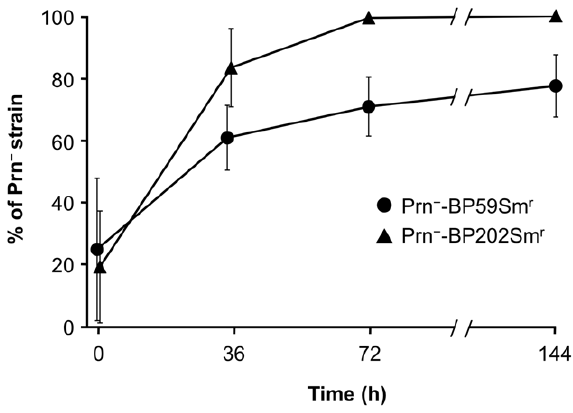
Figure 6. Population dynamics of Prn 2 strains in in vitro growth competition assay. Prn + back-mutants and parental Prn 2 strains were mixed in the ratio 4:1 (Prn + -BP59Sm r versus BP59Sm r or Prn + -BP202Sm r versus BP202Sm r ) and cocultured in mSS broth at 36 u C. The bacterial cultures were collected at 0, 36, 72 and 144 h, and plated on CSM agar plates. The representation of Prn 2 strains among 40 colonies was examined by colony-PCR. Data are means and standard deviations from 3 independent